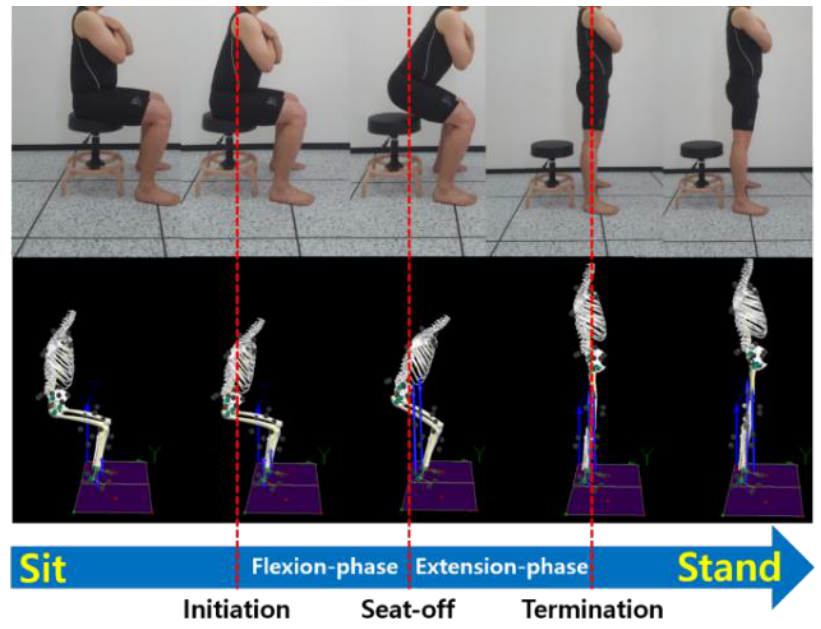
Figure 5. Indices and classification of the standing-up position from the sitting position.